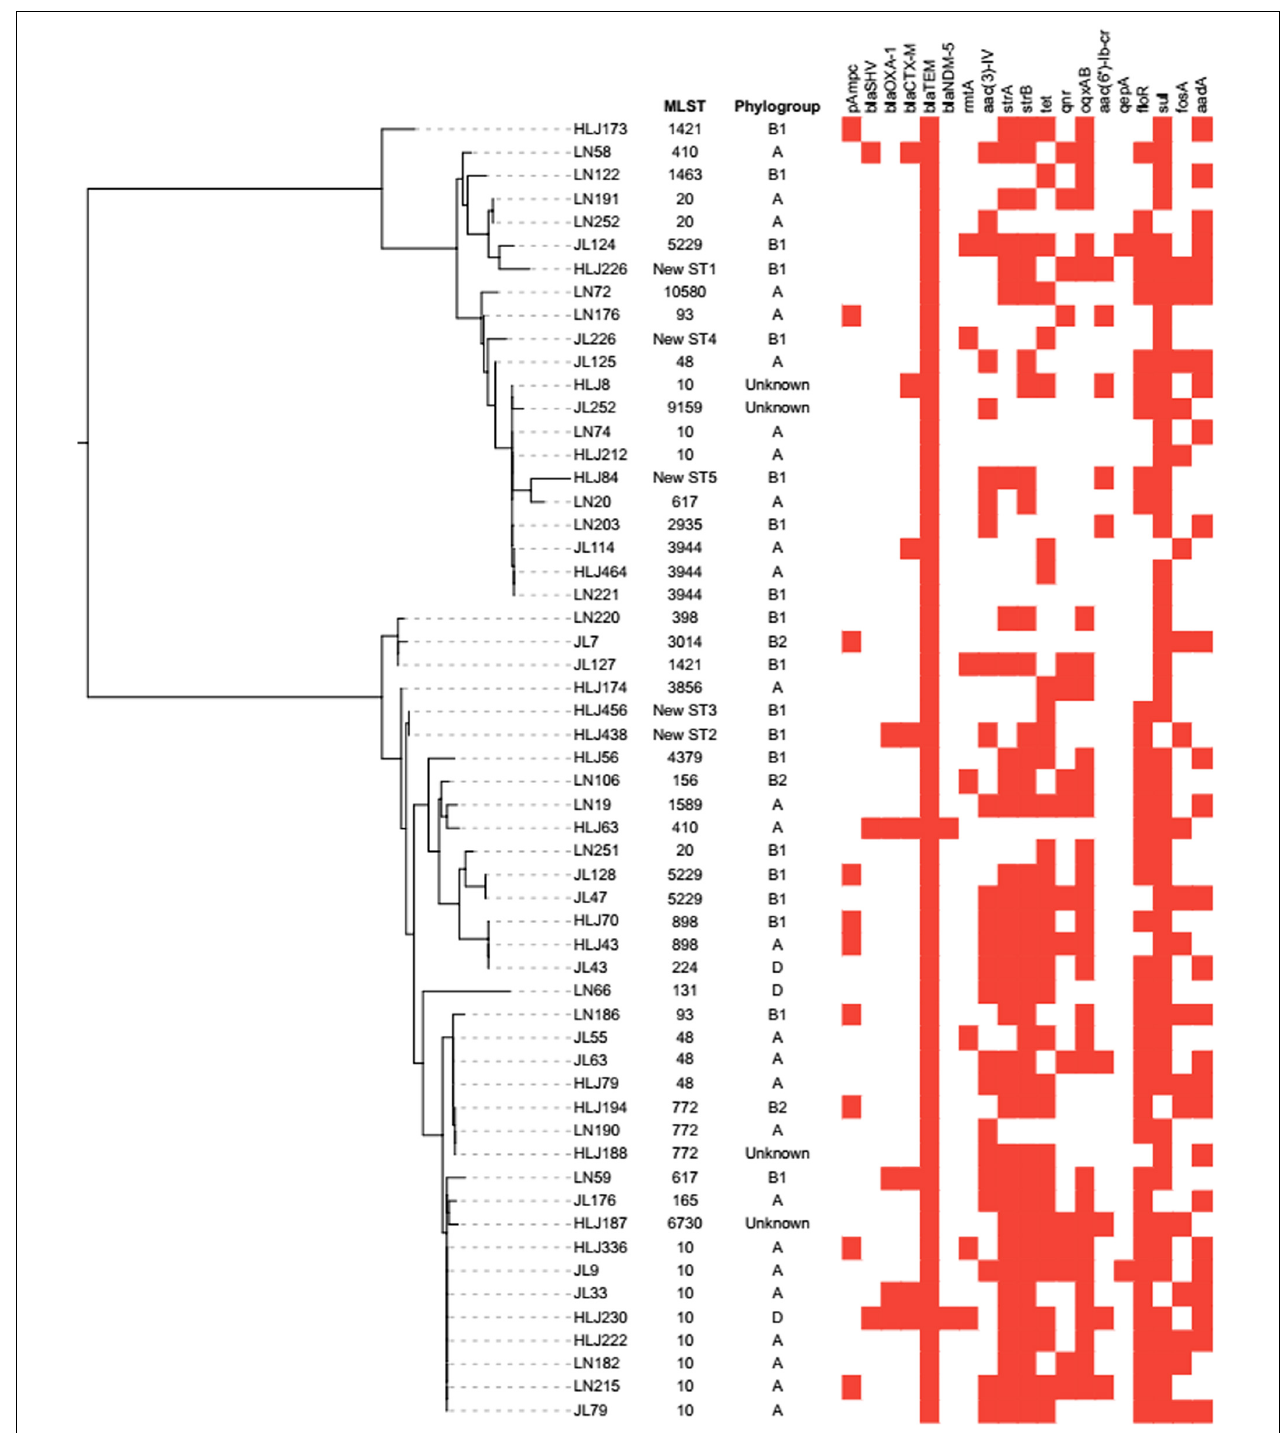
FIGURE 2 | Analysis of phylogroup, antimicrobial resistance genes, and relationships among 56 mcr-1 -positive E. coli isolates from swine farms in northeastern China. Relationships among 56 mcr-1 -positive E. coli isolates are indicated using an unrooted tree based on the alignments of concatenated MLST allelic sequences using the neighbor-joining method. For comparison of resistance genes among the 56 mcr-1 -positive E. coli isolates, the red squares represent positivity for antimicrobial resistance genes.